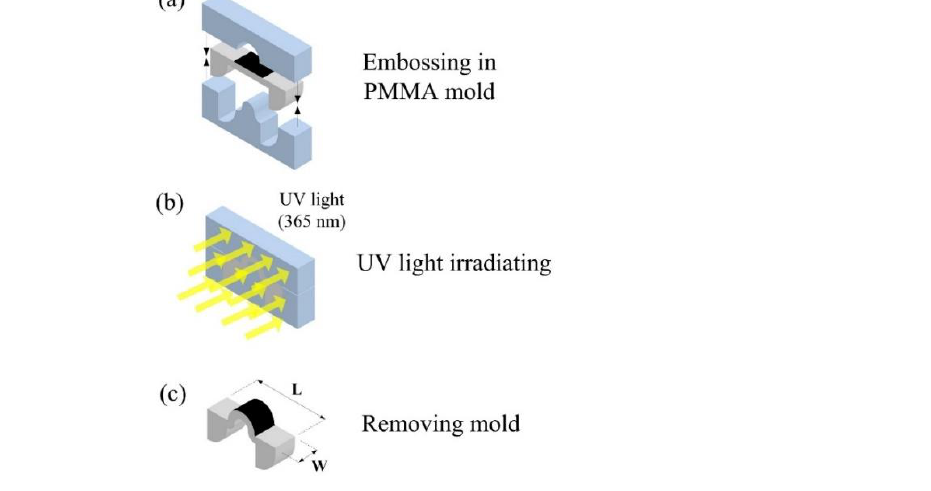
Figure 3. The shape programming process for realizing the arched actuator with PTF.